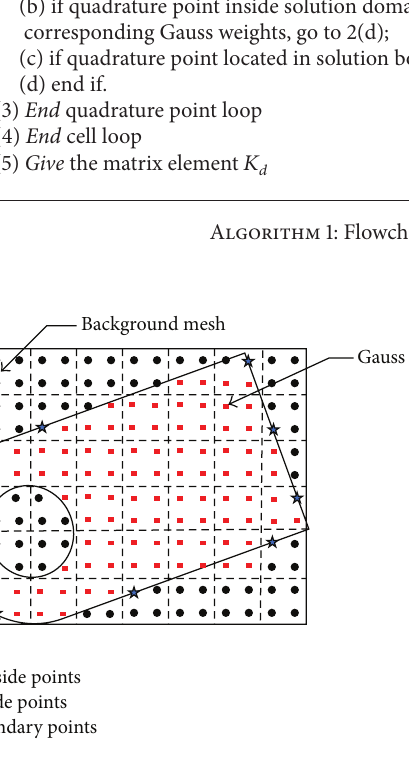
Figure 1: The scheme of background mesh quadrature